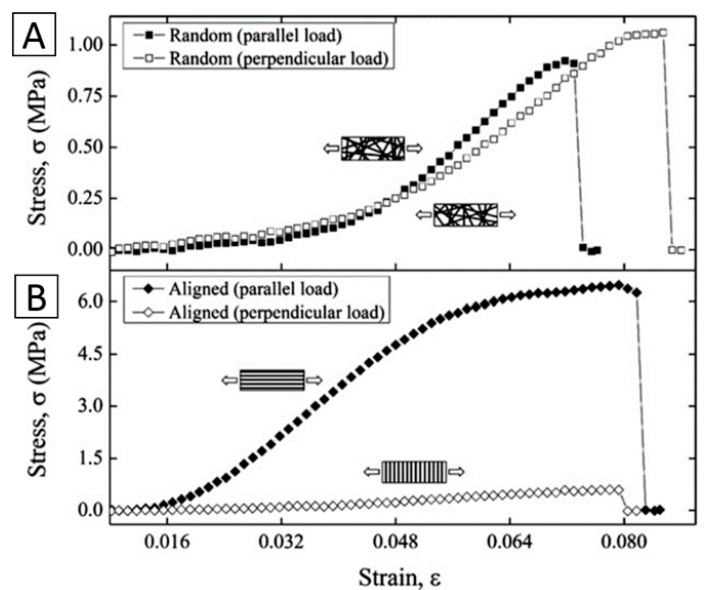
Figure 5. A comparison of stress ‐ strain curves of ( A ) randomly oriented and ( B ) aligned electrospun gelatin mats under two different loading orientations. Reproduced from [52], with permission from © 2013 Elsevier.